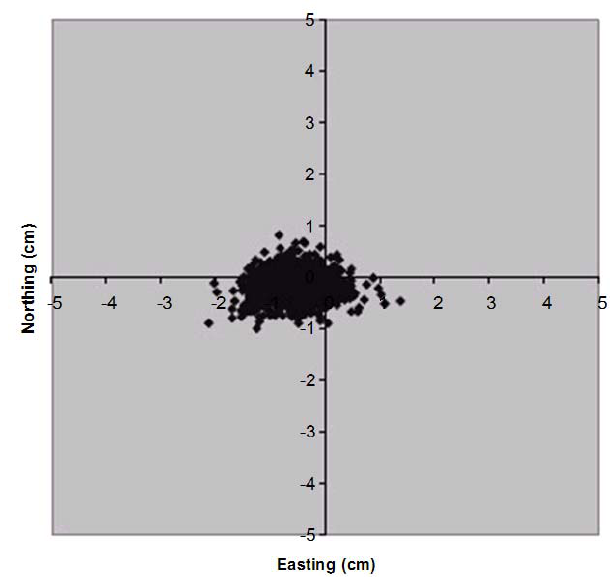
Figure 4. Scatter plot of the Real-Time Kinematic Global Positioning System (RTK-GPS) horizontal p x , y q position drift from the field evaluation over control survey stations.